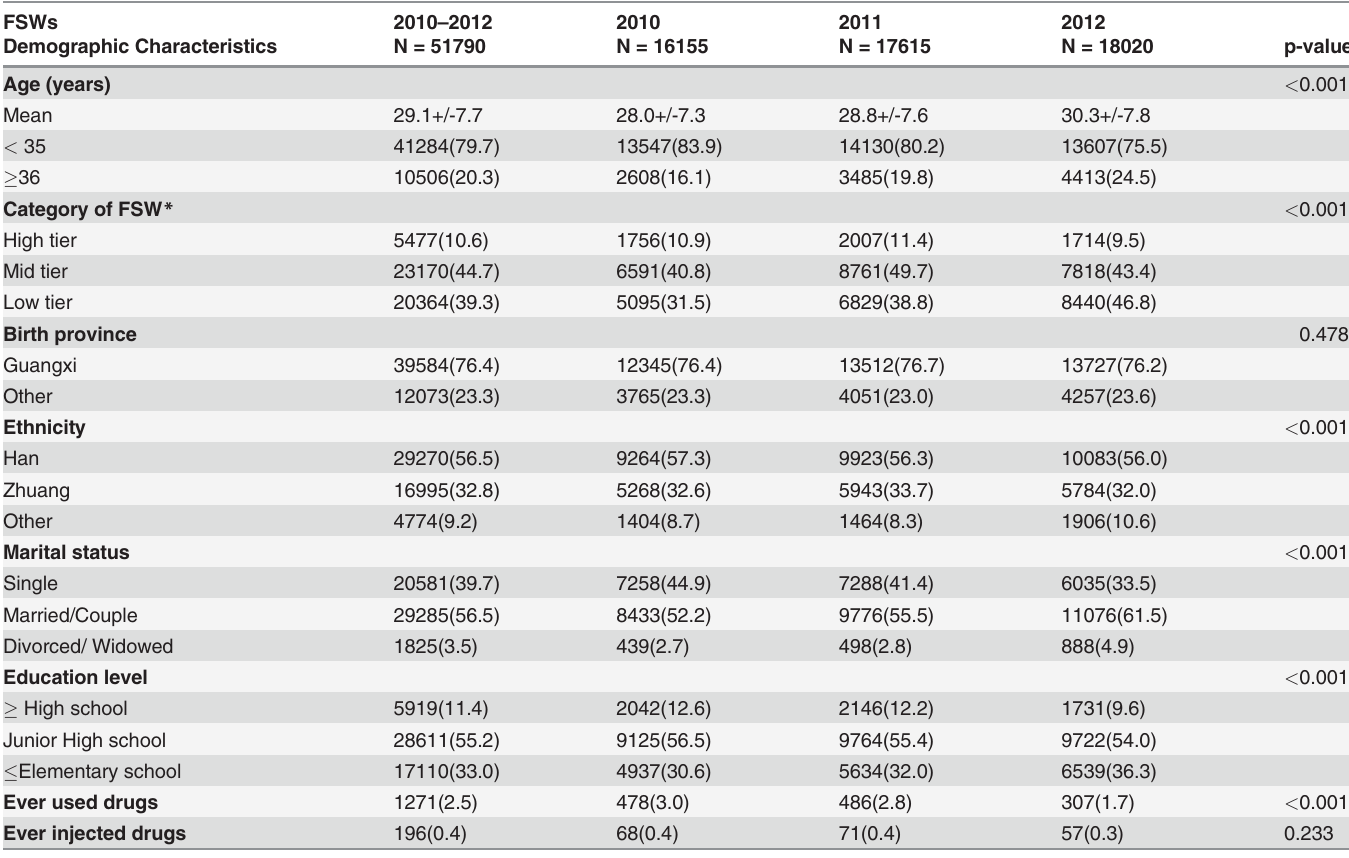
Table 1. Baseline demographics and characteristics of female sex workers (FSWs),Guangxi Province, China; China National CDC HIV/AIDS Surveillance Data, 2010 – 2012,N =